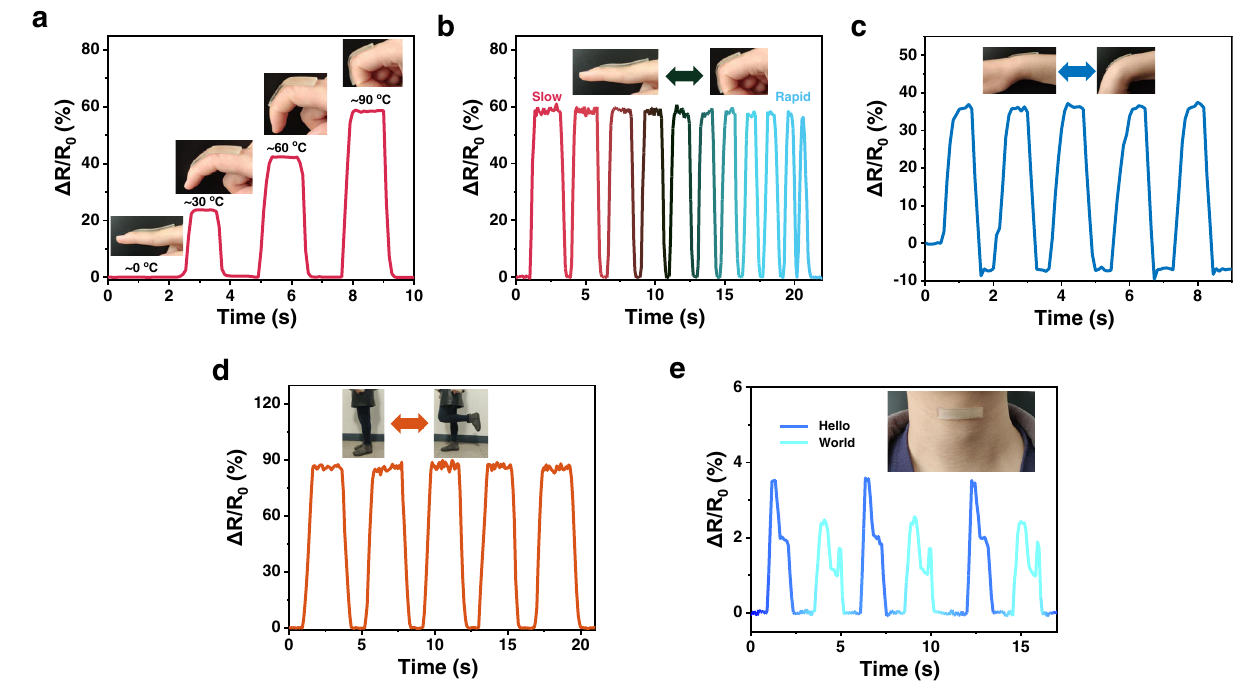
Fig. 7 | Human motion monitoring. a , b Monitoring fi nger bending to various angle ( a ) and different speeds ( b ). c – e Monitoring wrist bending ( c ), knee